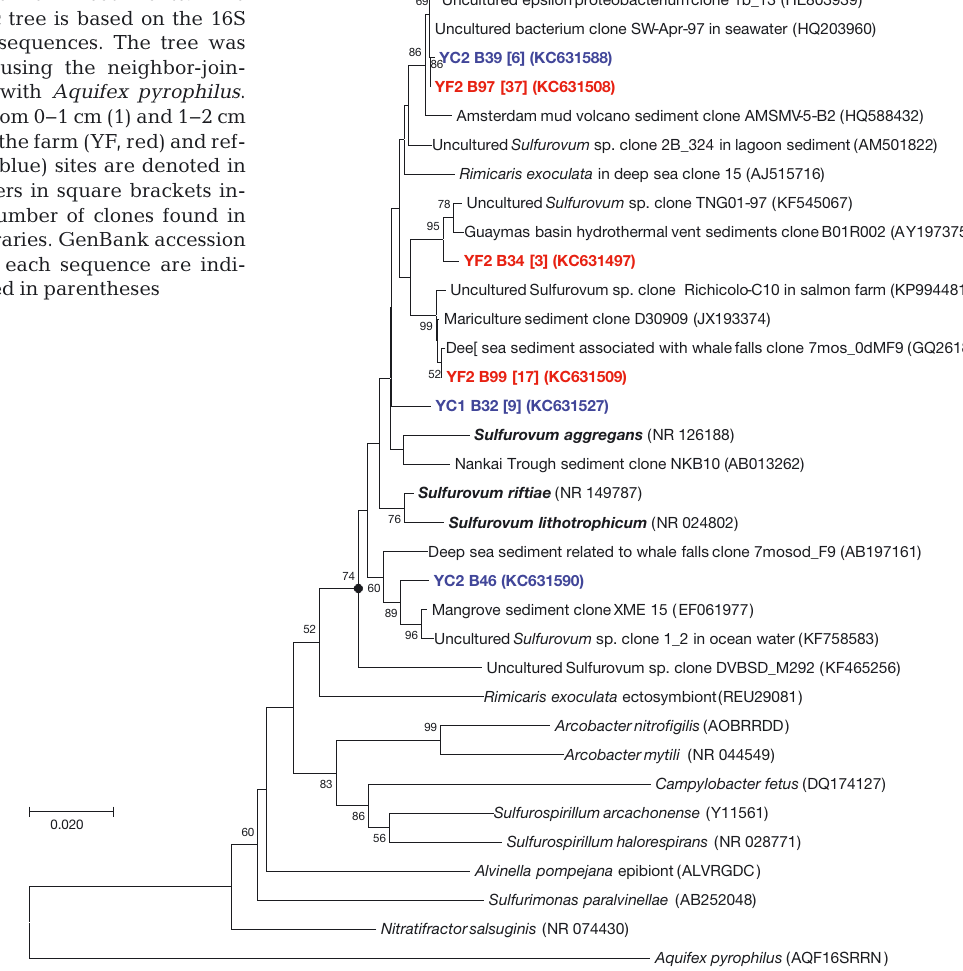
Fig. 5. Phylogenetic relationships of epsilonproteobacterial clones obtained from the fish-farm sediments. The phylogenetic tree is based on the 16S rRNA gene sequences. The tree was constructed using the neighbor-join- ing method with Aquifex pyrophilus . The clones from 0−1 cm (1) and 1−2 cm (2) depths at the farm (YF, red) and ref- erence (YC, blue) sites are denoted in bold . Numbers in square brackets in- dicate the number of clones found in the clone libraries. GenBank accession numbers for each sequence are indi- cated in